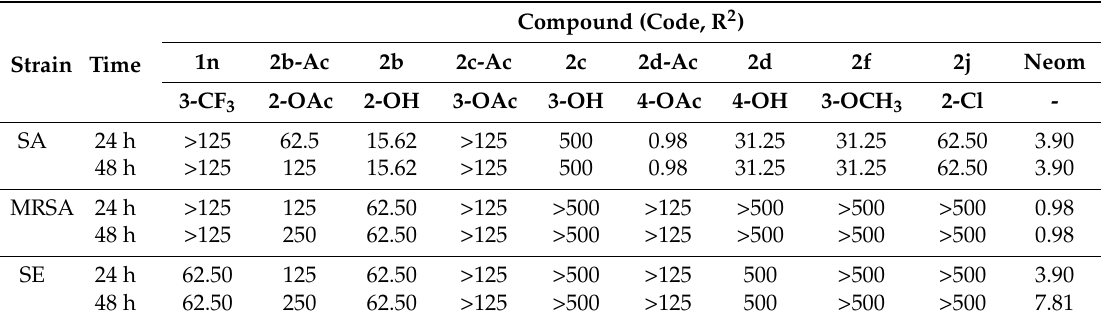
Table 3. Antibacterial activity of selected compounds expressed as MIC ( µ M) in comparison with standard